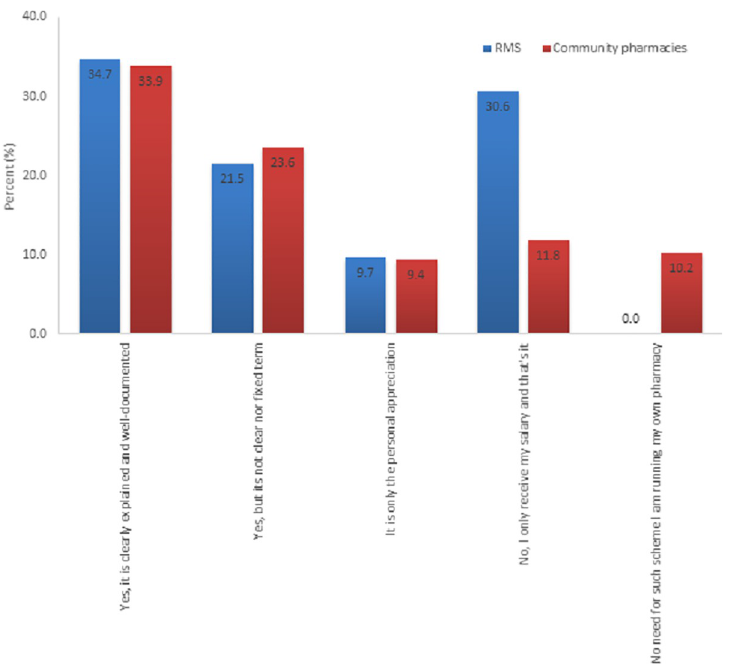
Fig 3. The presence of reward or intensive scheme for good working and superior achievements in Royal Medical Services and Community Pharmacies.